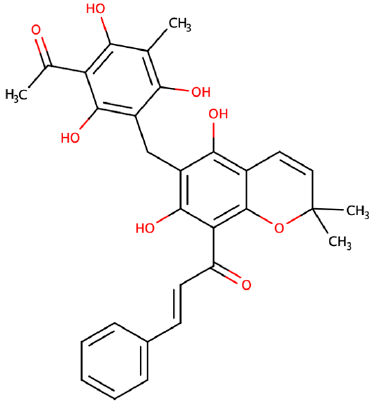
Figure 1. Chemical structure of Rottlerin (RoT).